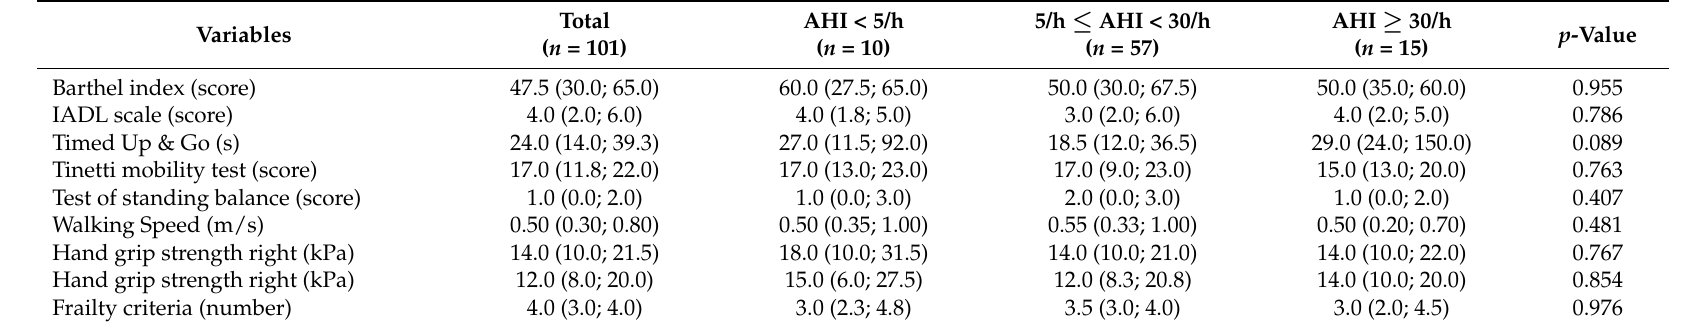
Table A5. Mobility also split by alternative AHI